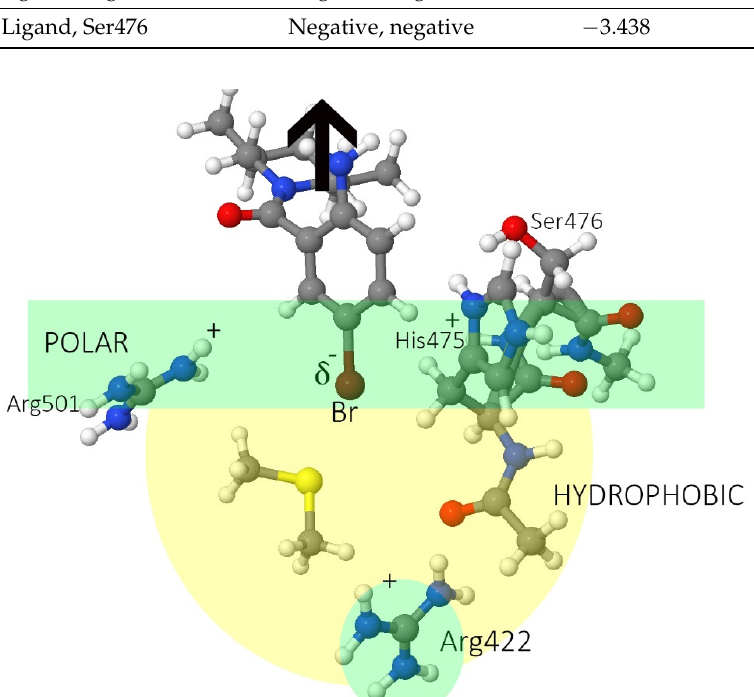
Figure 6. Representation of the charges in the allosteric site as the 3CJ2 ligand moves away (upwards), showing how the bromine from the bromo-aryl moiety affects the energy landscape. As the ligand moves away from the pocket, the bromine interacts with the positive charges in the outer part of the pocket, leading to a small segment where the system’s energy becomes more negative as the ligand moves away, which explains segment 3.